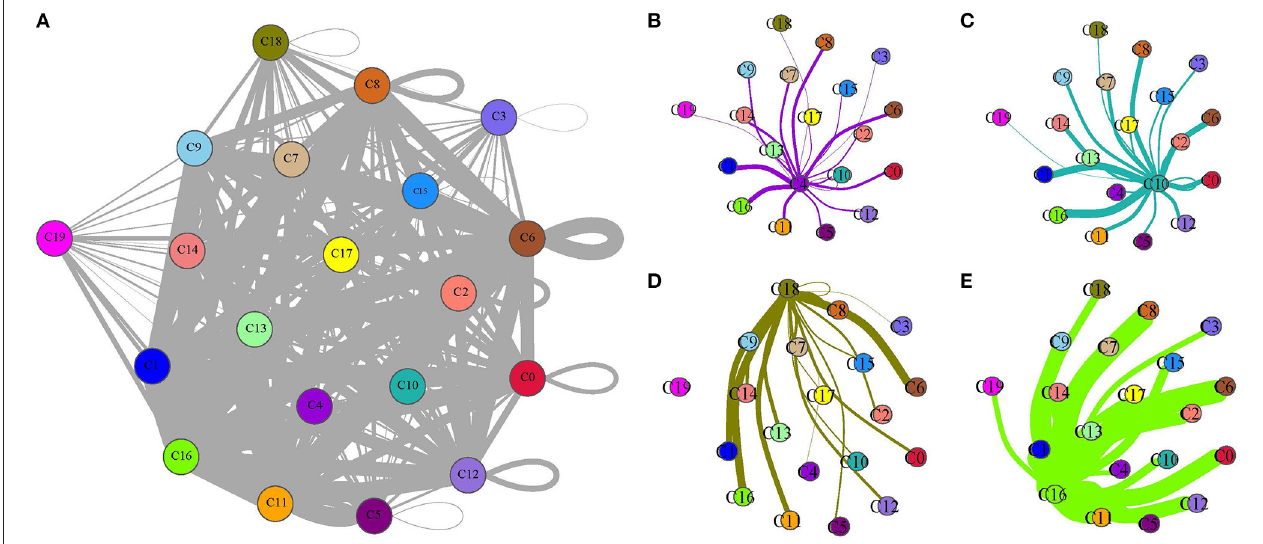
FIGURE 8 | Ligand–receptor interactions among 20 subgroups analyzed by CellPhoneDB. (A) A network of ligand–receptor interactions among 20 subgroups. (B–E) Ligand–receptor interactions of B cell_1 (C4), B cell_2 (C10), cancer cell_3 (C18), and CD1C + _B dendritic cell_3 (C16) to other subgroups, respectively. Circles with different colors indicate different subgroups. Thick lines and fine lines between subgroups indicate strong and weak interactions between